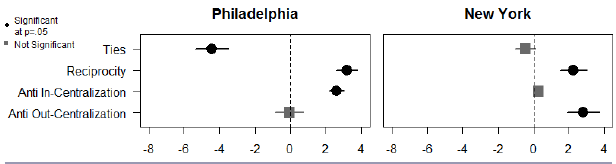
Fig. 3 . Odds ratios for Network exponential random graph (ERG) terms for Philadelphia and New York City ERG models.